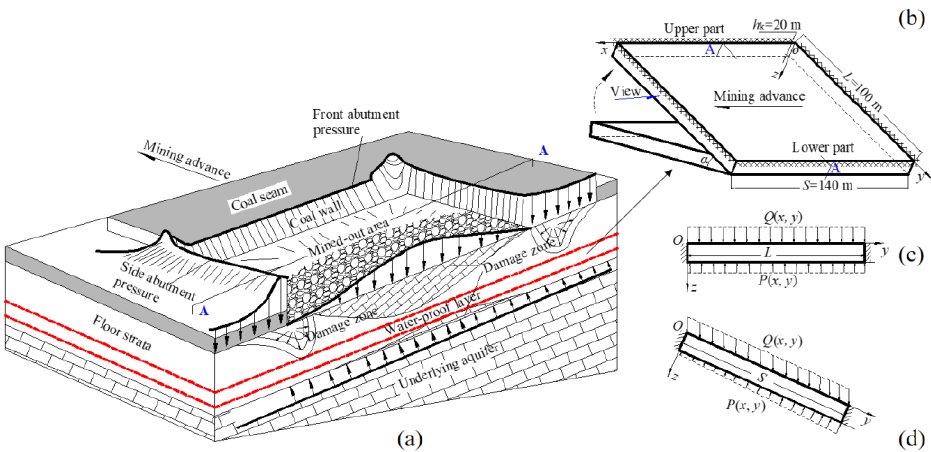
Figure 6. Analytical models for waterproof key strata. ( a ) Position of the waterproof layer; ( b ) horizontal or inclined key strata models; ( c ) profile A-A along the horizontal model; ( d ) profile A-A along the inclined model.